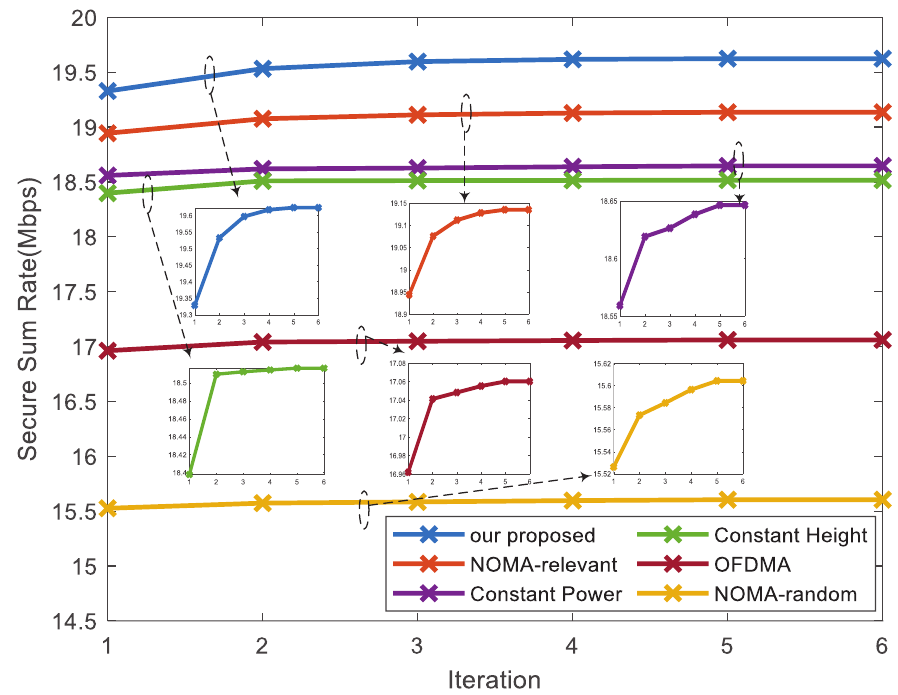
Figure 4. Convergence of different